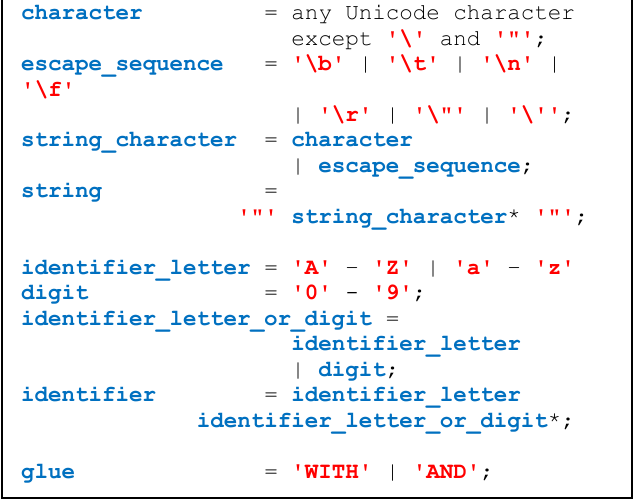
Fig. 2. Common DSL constructions.